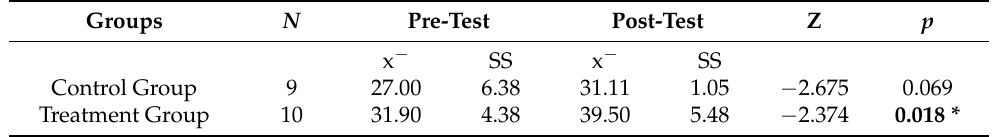
Table 6. Results Regarding Pre-Test-Post-Test Comparative Cause-Result Relationship Scale of Control and Treatment Group